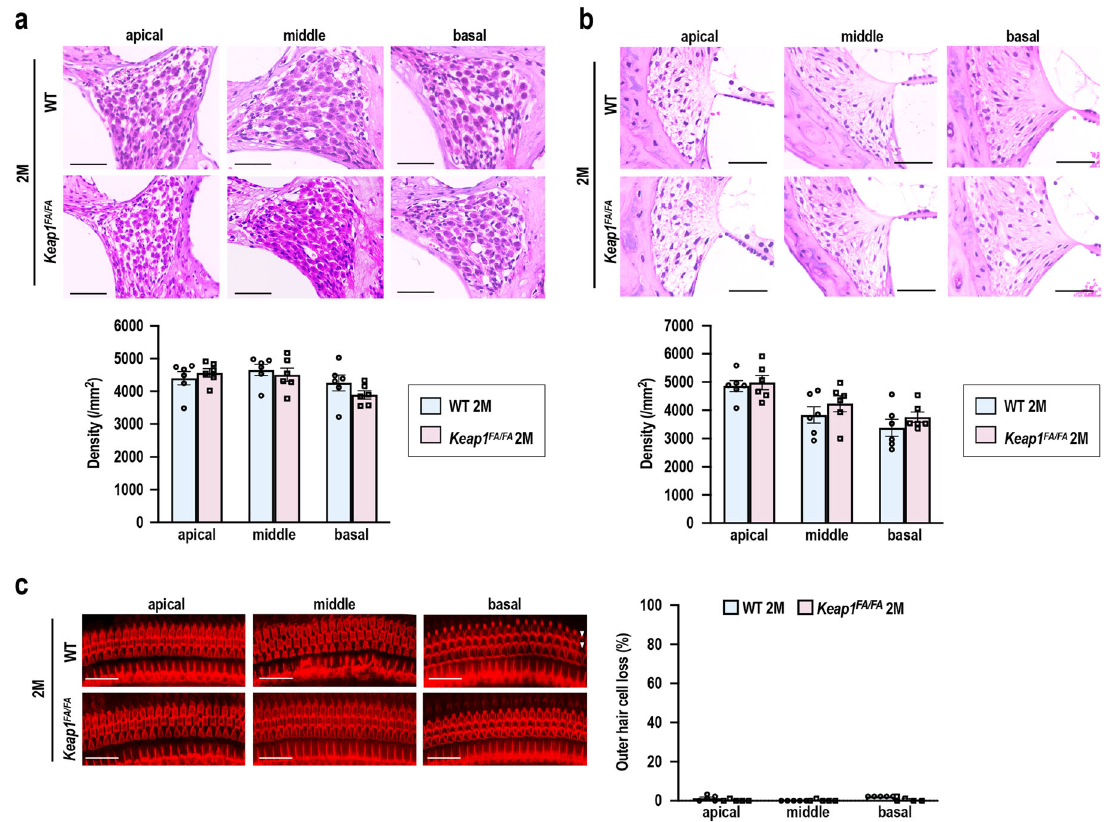
Fig. 5 Comparison of cochlear structure in the WT and Keap1 FA/FA mice at 2 months of age. a , b Cochlear histology at each turn. The SGN density ( a ) and density of the SL fi brocytes ( b ) are shown ( n = 6 in each group). c Surface preparation images of the hair cells. Missing OHCs are indicated with white arrowheads. Missing OHCs were quantitatively analyzed by evaluating 90 OHCs at each turn ( n = 5 in each group). Data represent the mean ± SEM. Unpaired two-tailed Student ’ s t -test was applied. Differences between WT and Keap1 FA/FA mice were not statistically signi fi cant. The samples of the WT mice at 2 months of age are the same as those shown in Fig. 2. Scale bars correspond to 50 μ m ( a , b ) and 40 μ m ( c ).